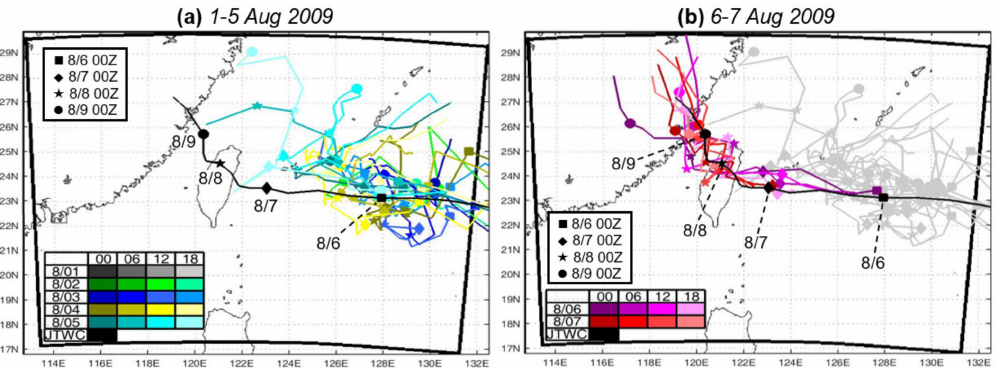
Figure 3. The best track (black) of TY Moarkot (2009) from the Joint Typhoon Warning Center (JTWC) and predicted tracks produced from the time-lagged ensemble every 6 h during ( a ) 0000 UTC 1 to 1800 UTC 5 August and ( b ) 0000 UTC 6 to 1800 UTC 7 August, respectively. Different colors and symbols (at 0000 UTC of each day) are used for the tracks (see